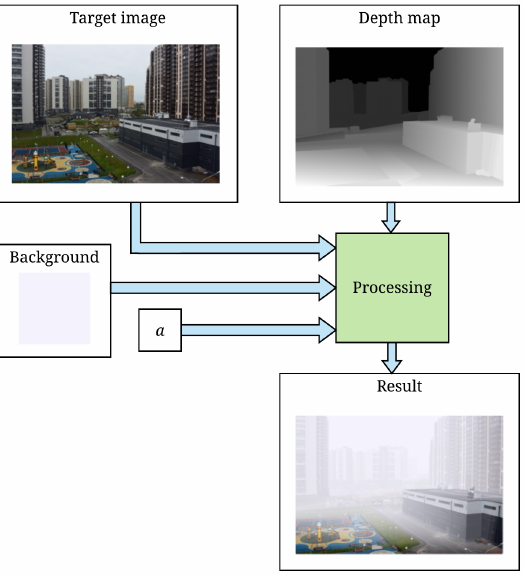
Figure 3. Block diagram of the aerial perspective enhancement